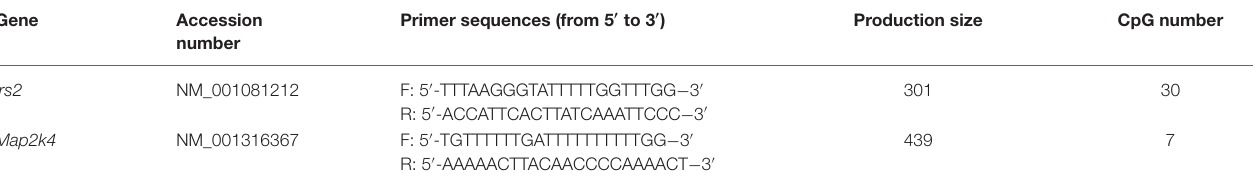
TABLE 1 | PCR primer for bisulfite sequencing.